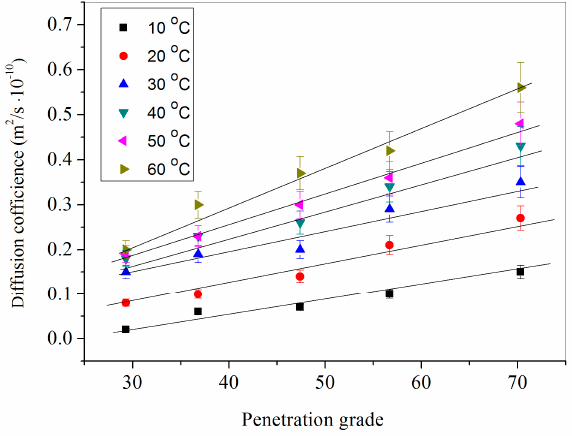
Figure 11. Diffusion coefficient values of microcapsules (content of 6%) in bitumen with different penetration grade values (29.7, 36.8, 47.6, 55.4 and 70.5) under a temperature range of 10 °C–60 °C.